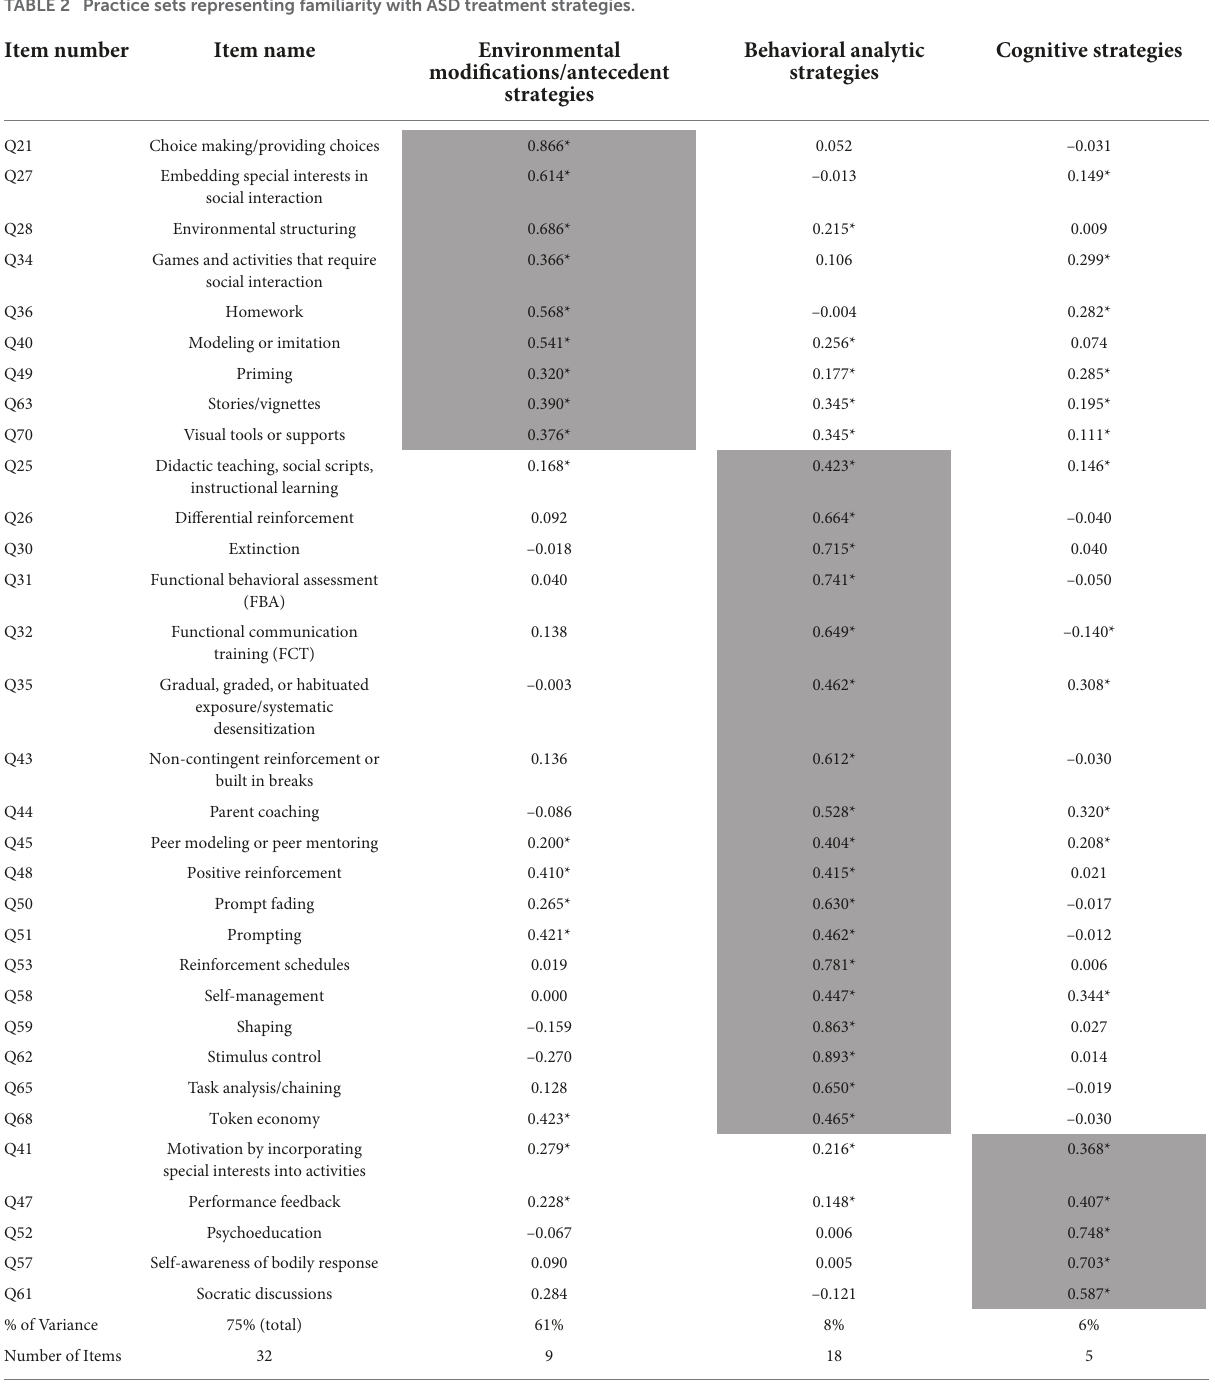
TABLE 2 Practice sets representing familiarity with ASD treatment